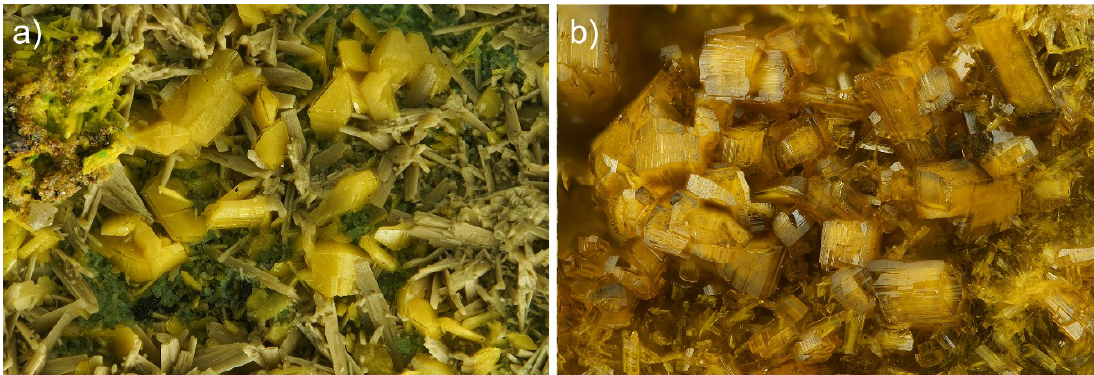
Figure 7. ( a ) Yellow dipyramidal crystals of soddyite associated with pale rutherfordine on a specimen from the Musunoi mine (Katanga province, DRC, Africa). Horizontal FOV is 2 mm (photo S. Wolfsried). ( b ) Orange dipyramidal crystals of soddyite with minor swamboite-(Nd) (prismatic, needle-like) on a specimen from the Swambo mine (Katanga province, DRC, Africa). Horizontal FOV is 2 mm (photo S. Wolfsried).